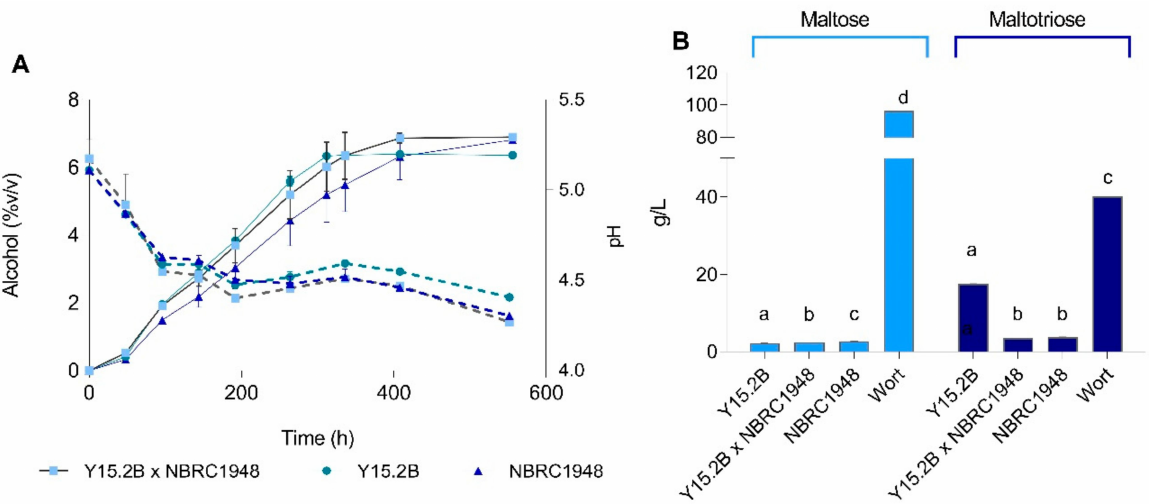
Figure 5. Wort fermentation at 2 L-scale (15 ◦ P, 12 ◦ C). Panel A exhibits trends of alcohol content (% v / v ) (solid line) and pH values (dotted line) over time, while panel B reports residual sugars (maltose and maltotriose) at the end of fermentation. Values are means of two independent replicates; bars represent error range. Different letters indicate significant differences ( p < 0.05) based on two-way